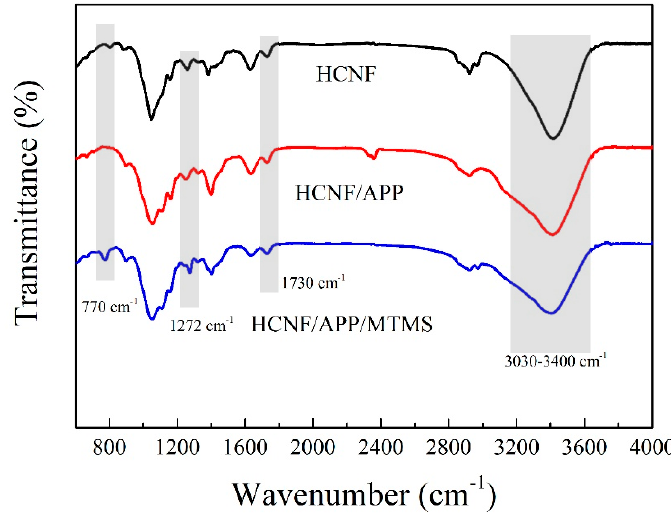
Figure 3. The FT-IR spectra of HCNF, HCNF/APP, and HCNF/APP/MTMS aerogels.